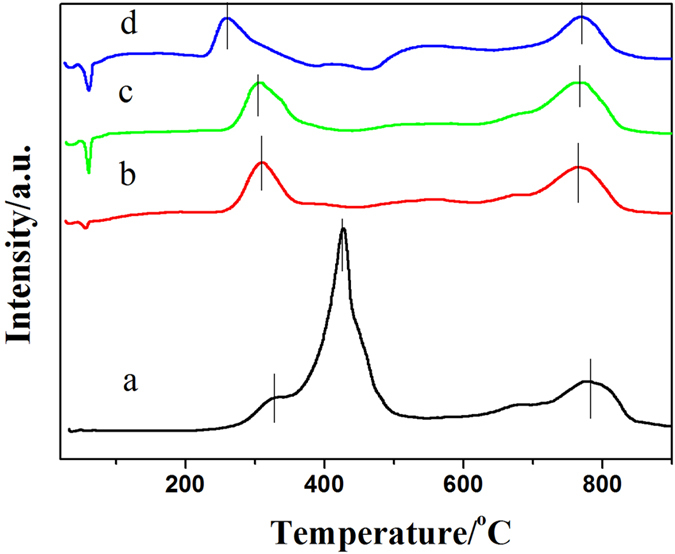
H2-TPR profiles of (a) LSM, (b) Pd/LSM-1, (c) Pd/LSM-2, (d) Pd/LSM-3.